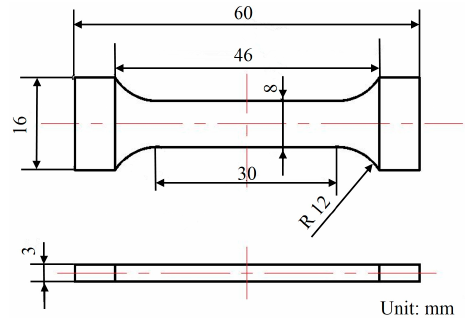
Figure 3. The dimensions of the tensile sample.